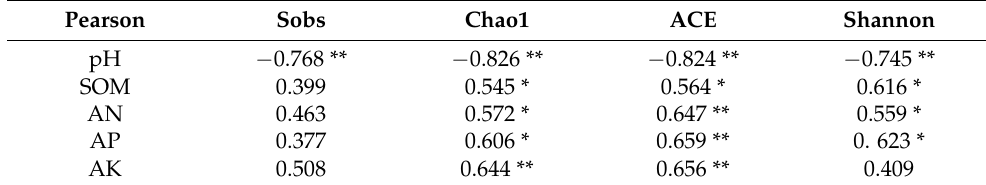
Table 3. Pearson’s correlation coefficients between soil physicochemical characteristics and Sobs, and diversity